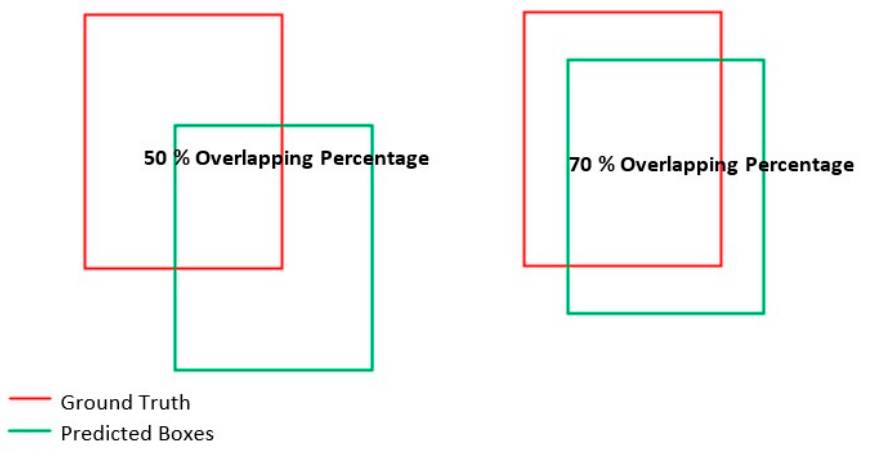
Figure 6. The intersection over union (IoU) method of overlapping percentage.